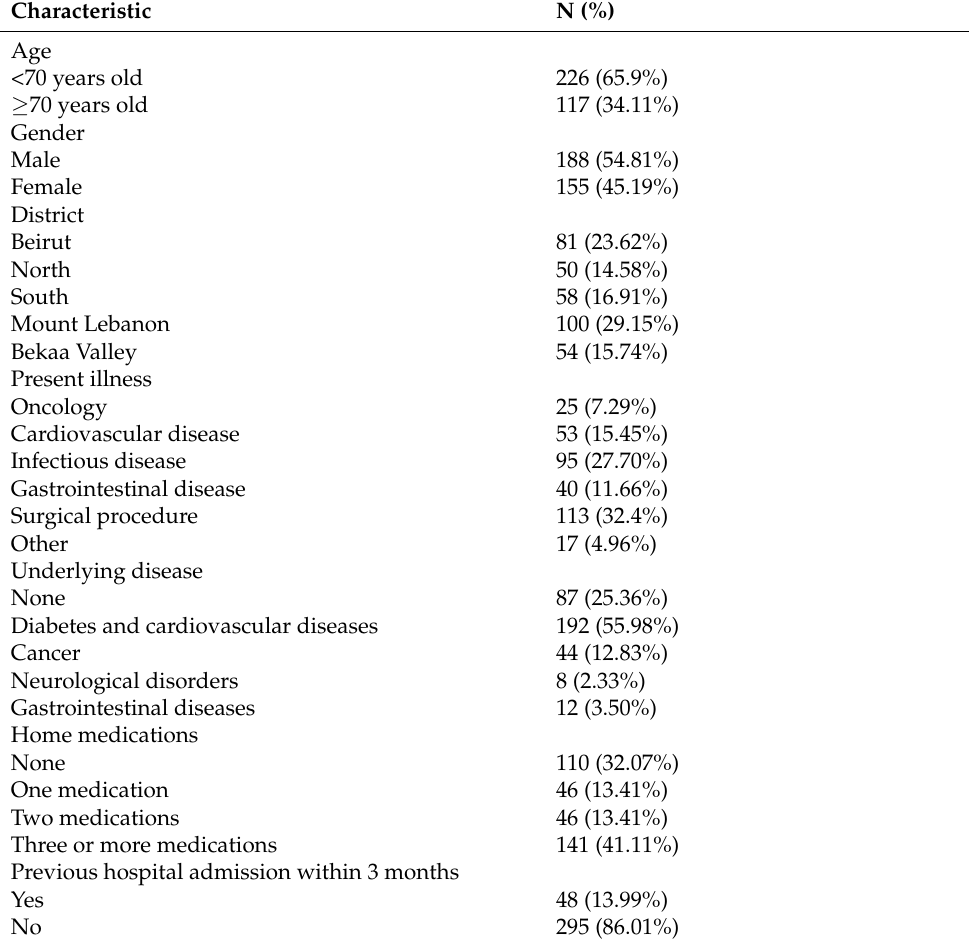
Table 2. Baseline characteristics of participants (N =